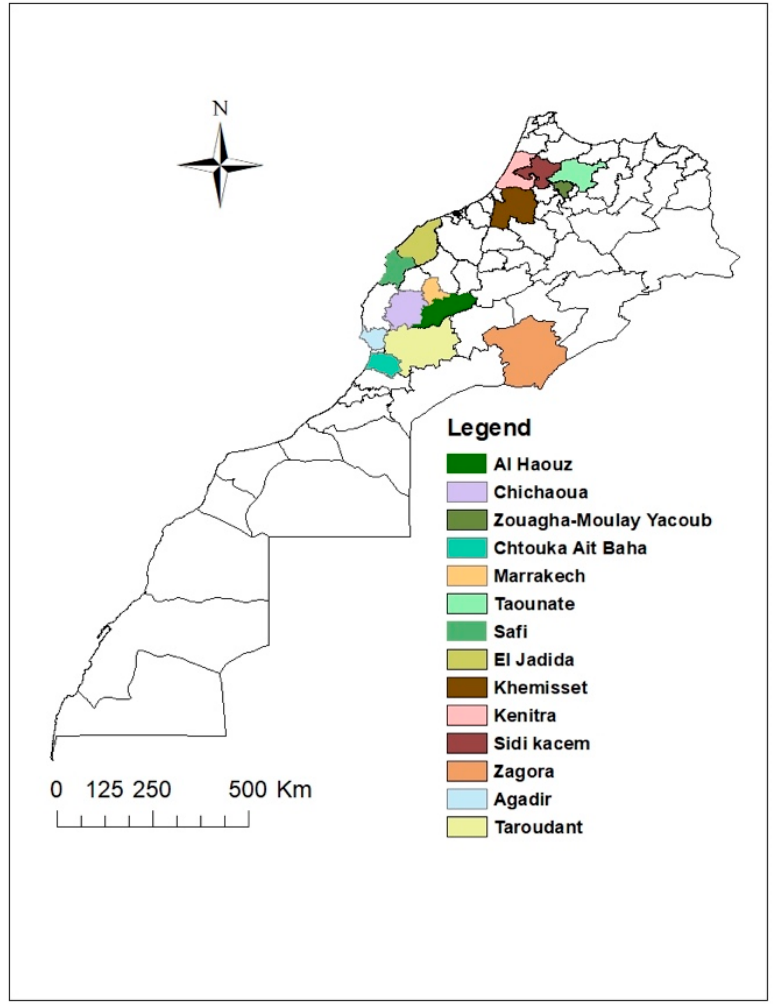
Figure 1. Map of Morocco showing the sites in which leaf tissues were collected. Table 1. Description of the 1333 samples collected during two growing seasons from different crop